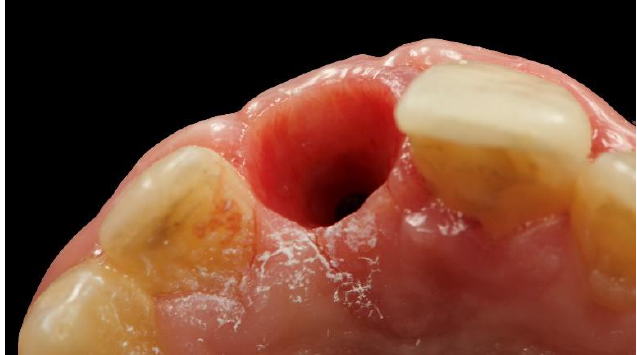
Figure 14. Transition zone showing good soft-tissue healing.